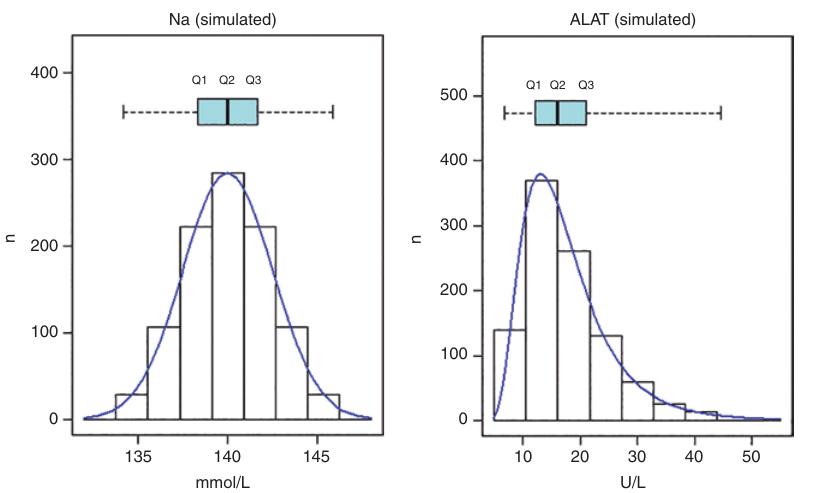
Figure 1: Boxplots and histograms of 1000 simulated sodium ( μ = 140, σ = 2.5) and ALAT values ( μ log = 2.6, σ log = 0.49, shift = 2.5). The boxes extend from the 25 th to 75 th percentile ( Q 1, Q 3) and the thick vertical line represents the median ( Q 2). If the distribution of the central 50% of the values is symmetric, the two halves of the box ( Q 2 − Q 1 and Q 3 − Q 2) are equal and their difference – the numerator of the fraction – becomes 0. If the distribution is right-skewed, the right half will be larger than the left one, and the difference will become positive. The denominator Q 3 − Q 1 (interquartile range, IQR) serves to standardize BS to a range from −1 to +